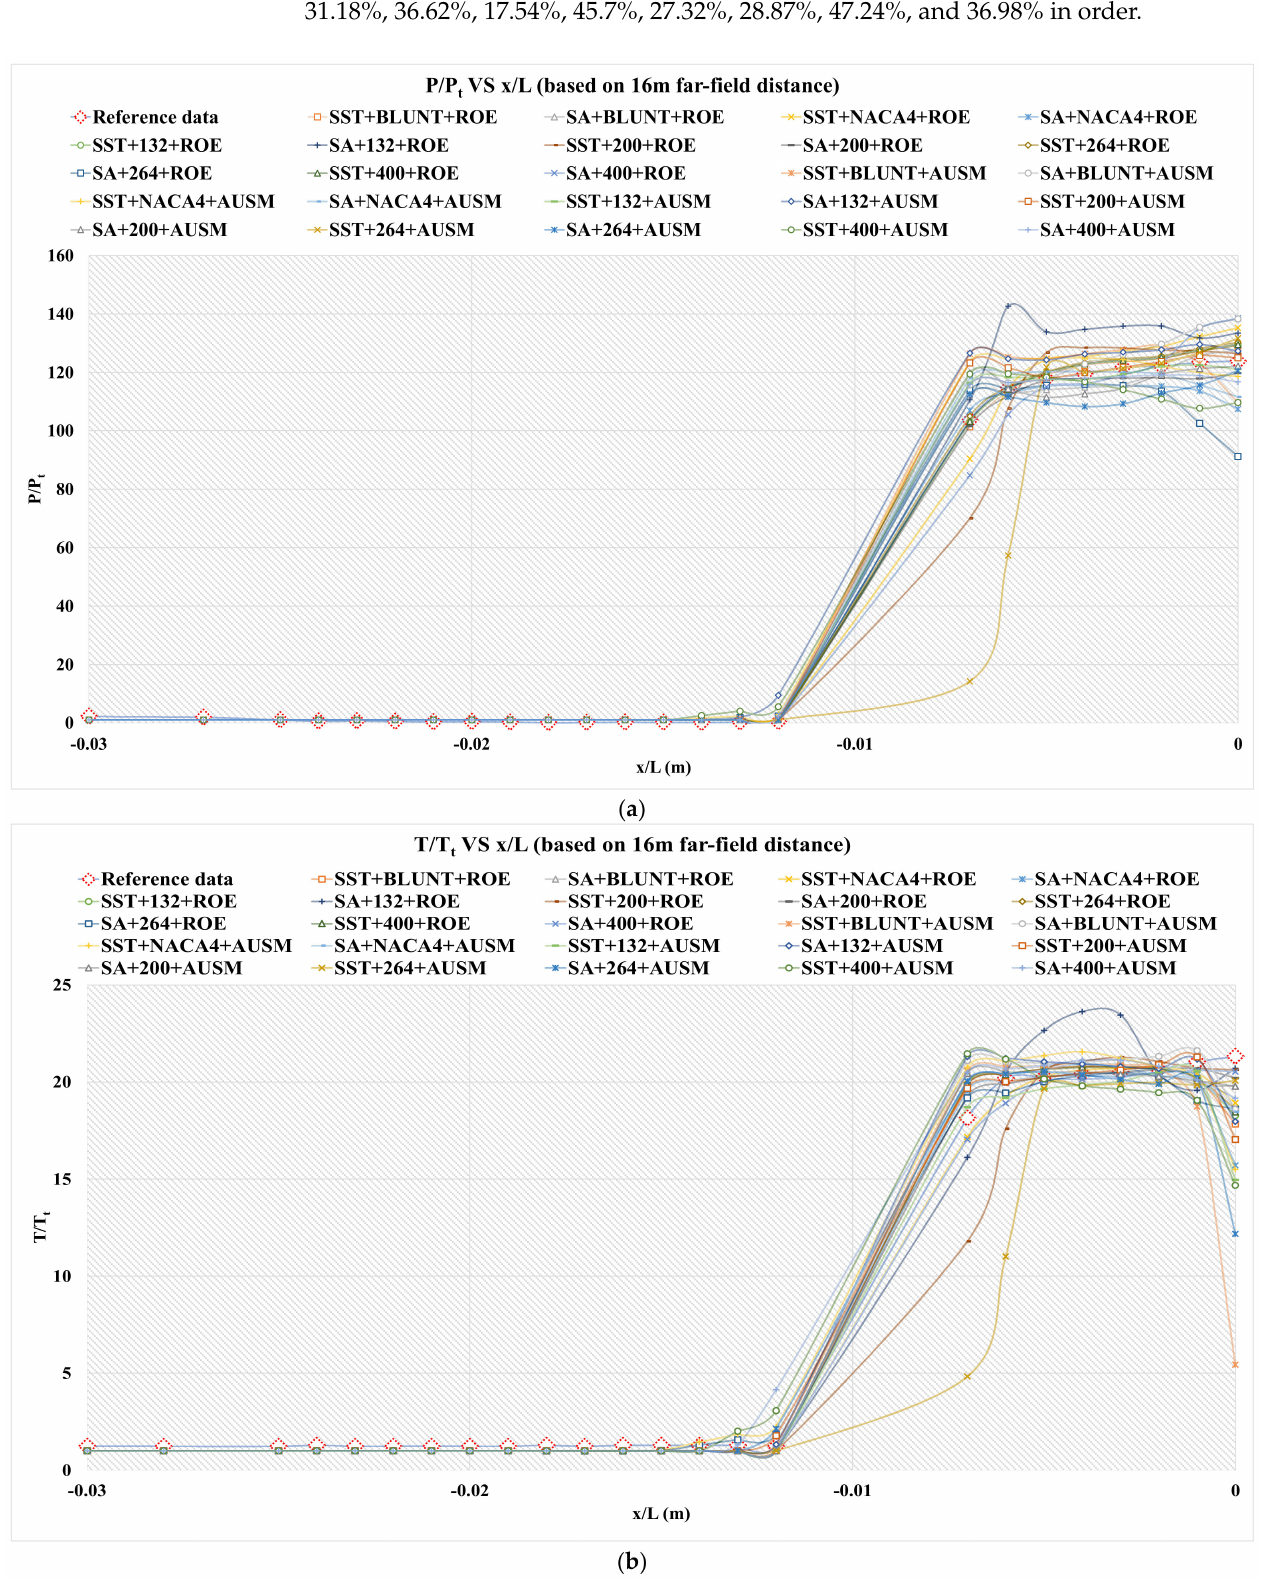
Figure 25. ( a ) Distributions of P/P t of 16 m far-field distance; ( b ) Distributions of T/T t of 16 m far-field